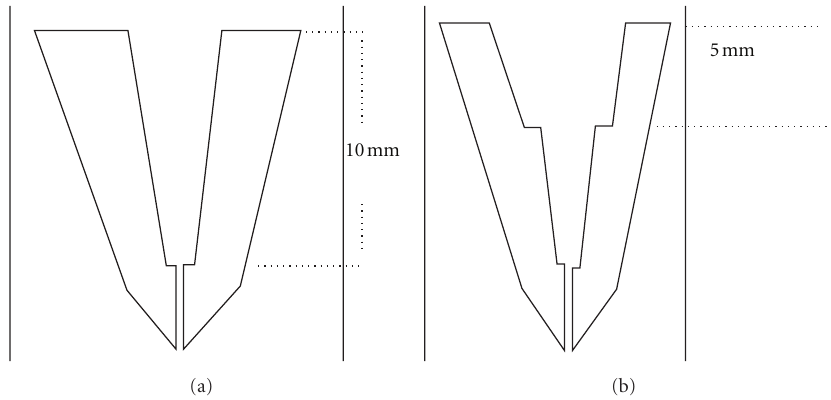
Figure 1: Schematic diagram showing root weakening procedures. (a) Coronal 10 mm of prepared canal was overprepared using luscent helix reamers. (b) A specialized stainless steel bur with diameter 3 mm at the tip and 4.5 mm at body was used to enlarge the coronal 5mm of previously overprepared